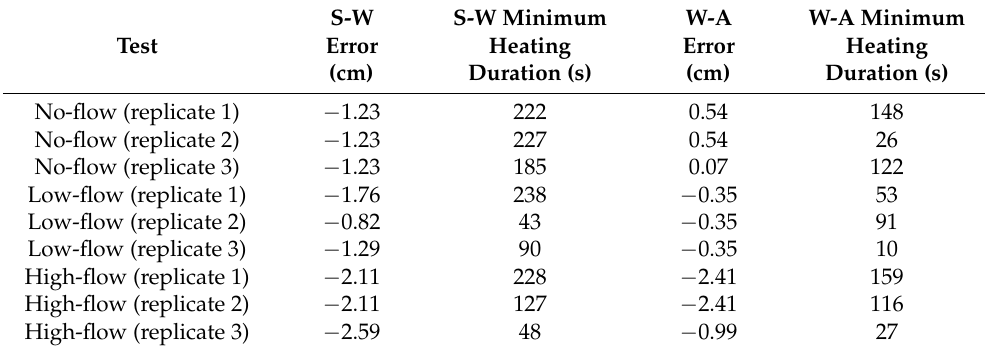
Figure 5. The mean temperature-increase profiles for the different testing conditions and a comparison between the detected locations of the interfaces versus their actual locations. The markers used to distinguish the ∆𝑇 and the gradient signals are added at every five measurements for clarity purposes. Table 1. Errors in the estimated S-W and W-A interfaces and the minimum heating duration needed to obtain a stable measurement for the different tested